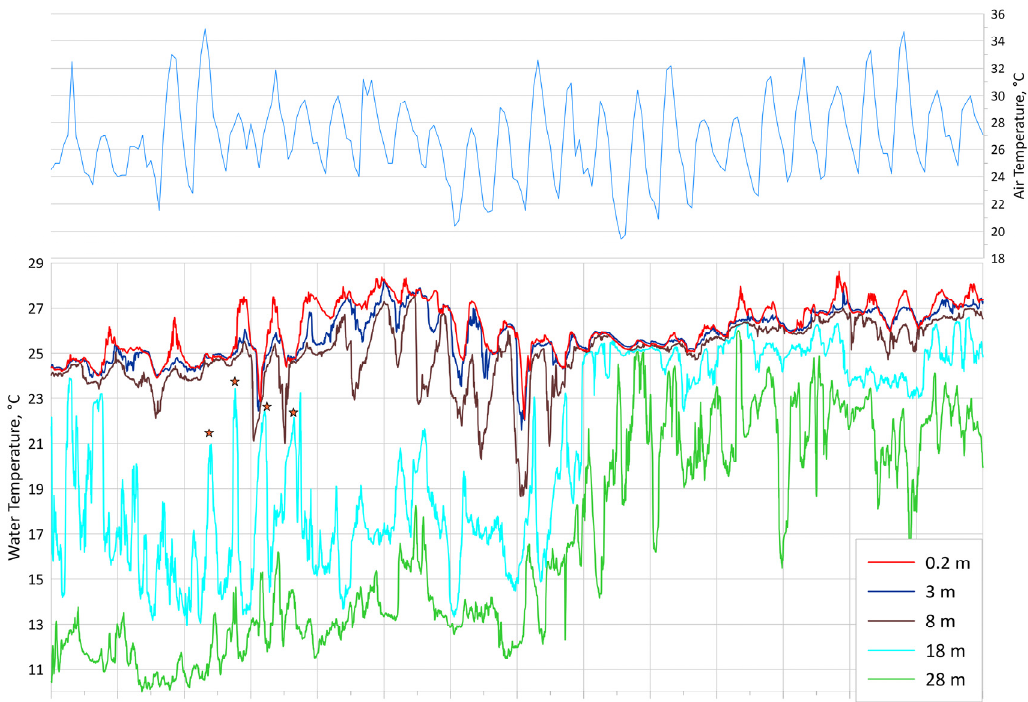
Figure 13. Anomalous diurnal cycle in July 2021. Red stars mark 17 h oscillation. Water temperature according to the data of the thermistor chain—bottom panel. Air temperature according to the Anapa weather station data—upper panel.